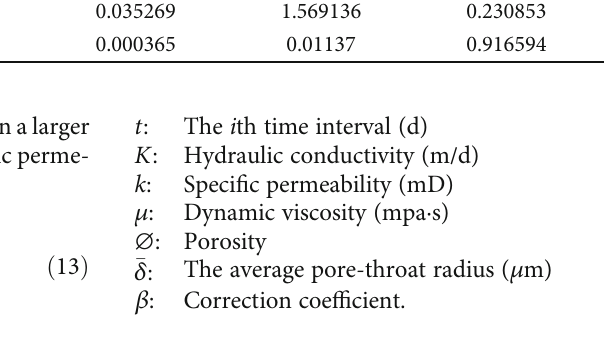
Table 11: Tests for signi fi cant di ff erences between corrected theoretical values and actual values. Di ff erence source